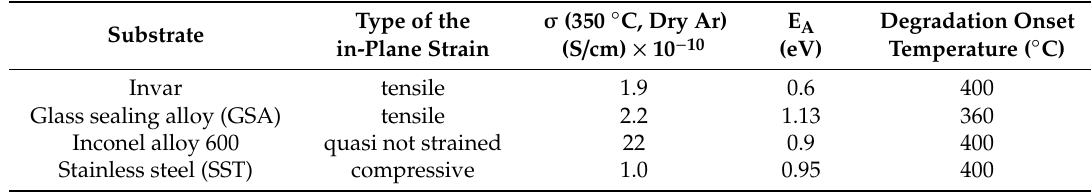
Table 2. Electrical properties of the barium cerate films deposited on different substrates at a temperature of 600 °C with 12 Å/s deposition rate.